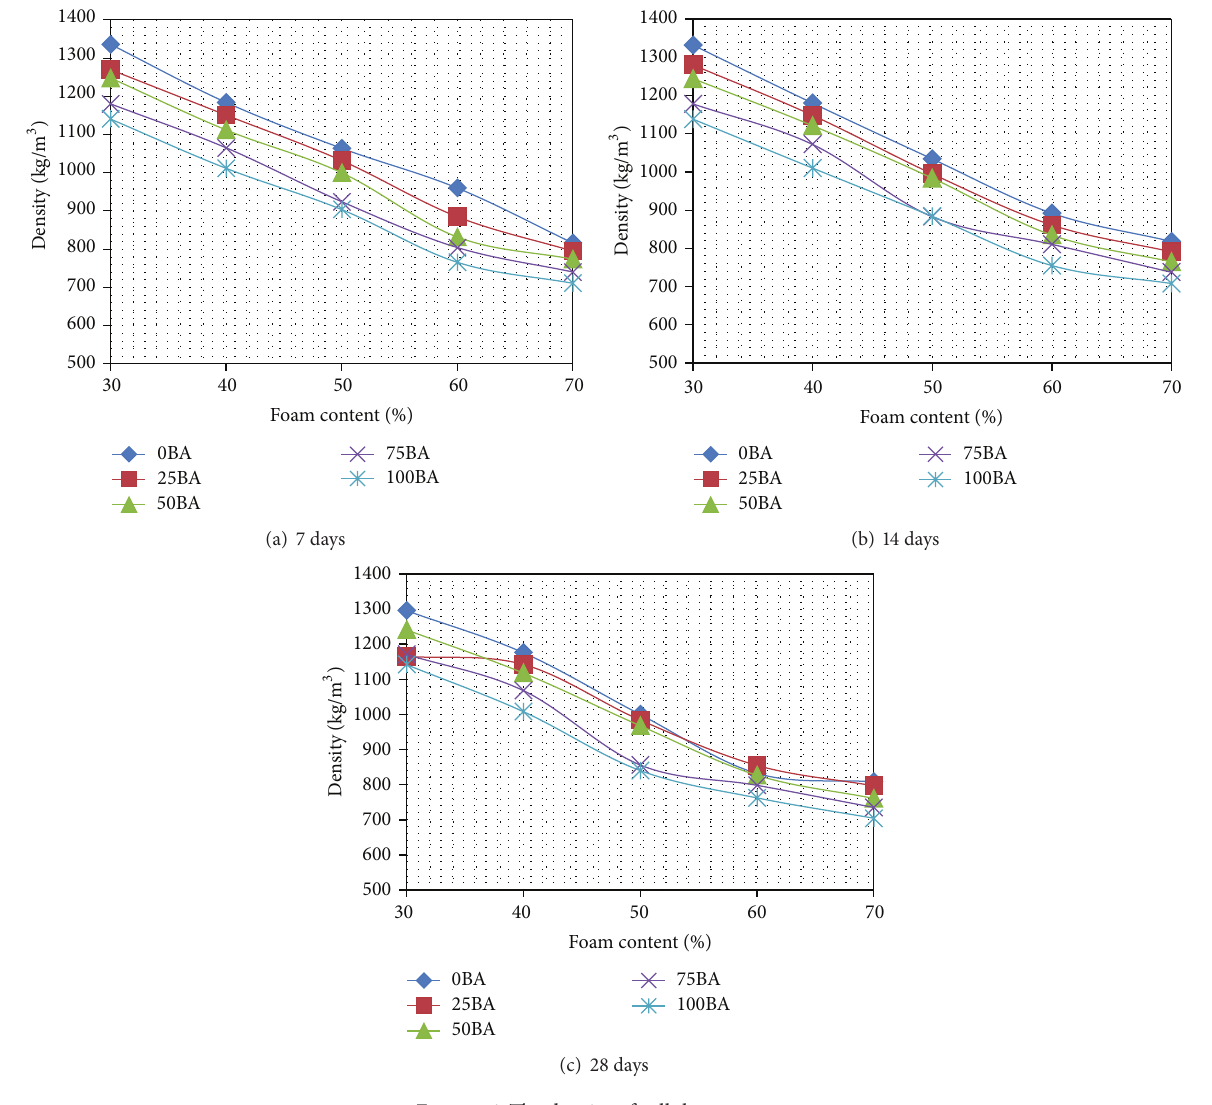
Figure 6: The density of cellular